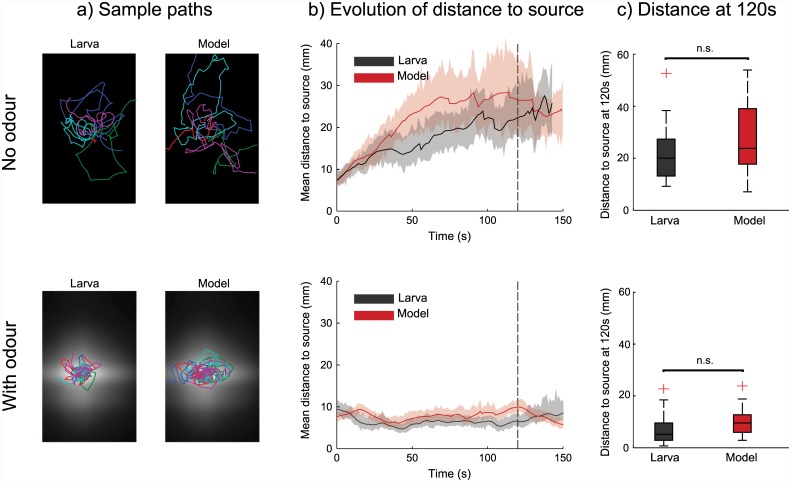
Near-source chemotaxis performance of real and simulated larvae.The first row shows performance of 42 real larvae and simulated larvae with no odour source present, while the second row shows performance of 19 real and simulated larvae with a point odour source of ethyl butyrate, as described in [19]. a) Sample paths of real and simulated larvae in this environment. The odour gradient is represented with black representing no odour and white representing maximal odour. b) Temporal evolution of the mean distances to the odour peak. Shaded areas show 95% confidence intervals. We use the odour peak position from the ‘odour’ condition to produce this metric for the ‘no odour’ condition. c) Boxplot of the distances to the peak after 120s. Boxes show the median and first and third quartiles; whiskers extend to the most extreme non outlier points, where points are considered outliers if they are more than 1.5 times the interquartile distance from the nearest quartile. Distances for the larva and model are not shown to be statistically different for either condition (Mann-Whitney U Test, p>0.05).